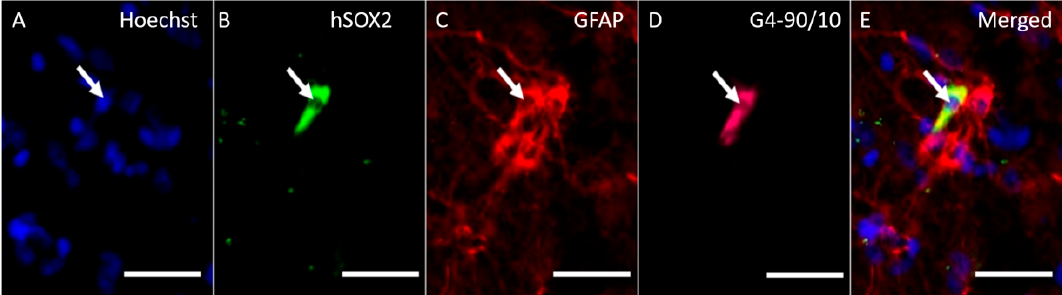
Figure 10. Image ( A ) shows cells labeled with Hoechst; image ( B ) shows citrine expression from the hSOX2 plasmid; image ( C ) shows glial fibrillary acidic protein (GFAP) expression; image ( D ) shows fluorescence from G4-90/10-Cy5.5; image ( E ) is the merge between all images, confirming that the G4-90/10-Cy5.5 dendrimers successfully delivered the large hSOX2 plasmid in vivo and were successfully taken up by the glial cells 72 h post-injection (scale bar: 100 µm).